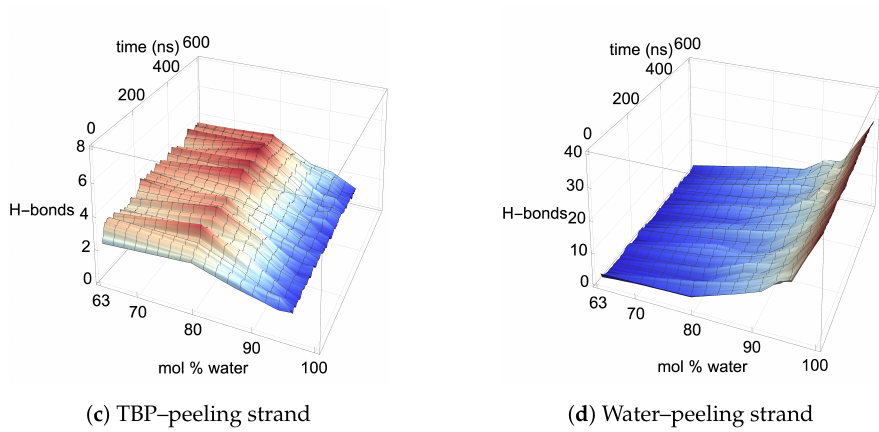
Figure A12. The hydrogen bonding for the second yellow separating strand at 360K (Part 1 of 2). The hydrogen bonds are shown between the following: ( a ) (bundle–peeling strand and peeling strand)–peeling strand (i.e., intra-strand and inter-strand hydrogen bonds for the separating strand); ( b ) Cl–peeling strand; ( c ) TBP–peeling strand; ( d ) water–peeling strand. These data represent the second yellow strand to peel or the non-peeling yellow strand if the second yellow strand does not peel in the simulation. The data were averaged over 1000 data points, using a rolling average. Every 100th point was then plotted to maintain plot clarity [64].